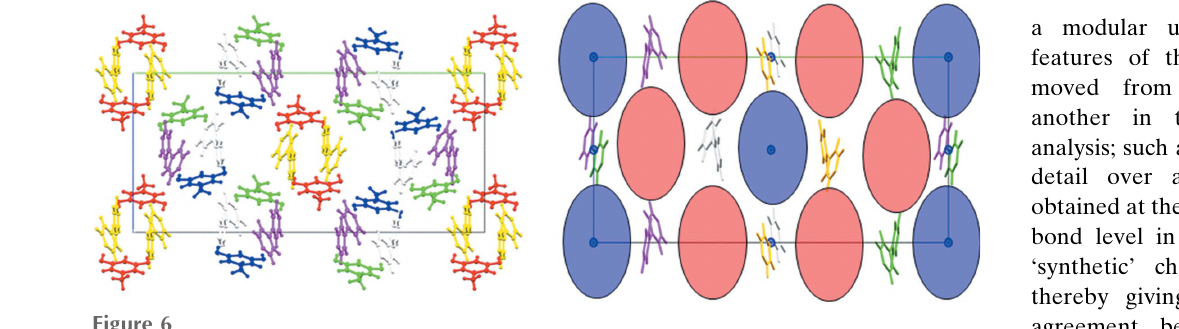
† Normalized: energy as a multiple of the (2:3) asymmetric unit. ‡ The calculation has been described in the supporting information. § Data collection at 150 K.